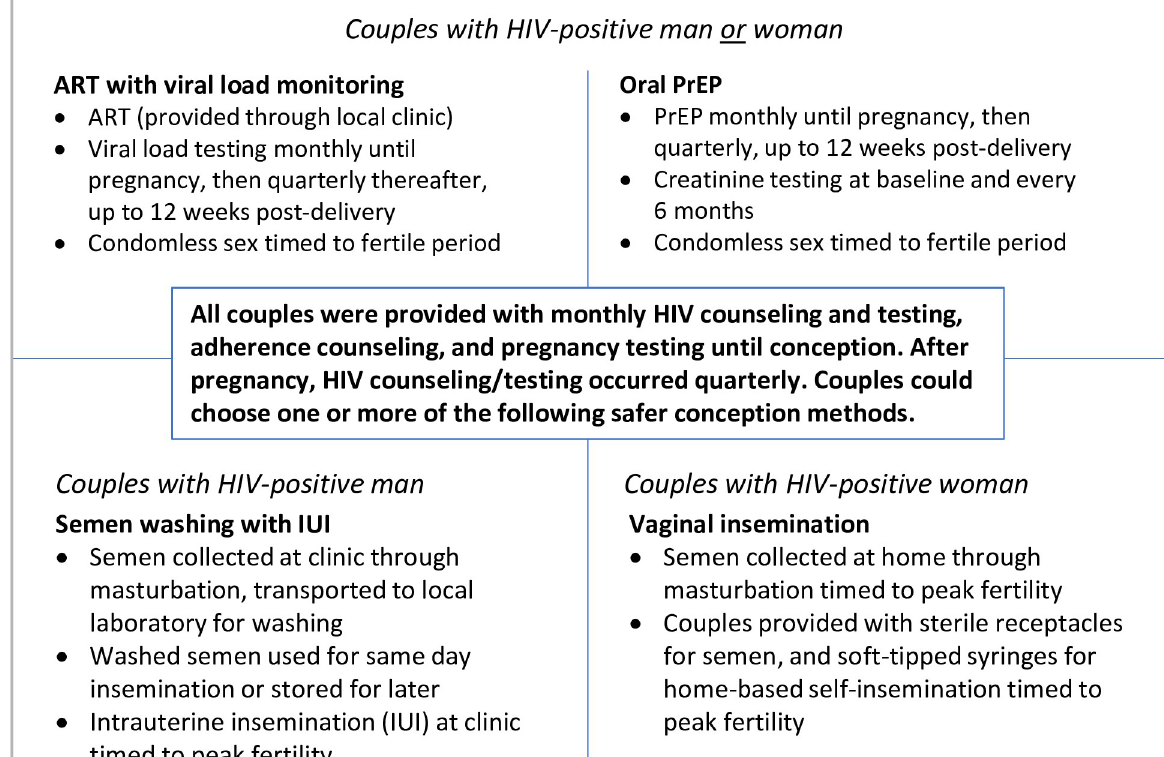
Fig 1. Safer conception methods offered in the